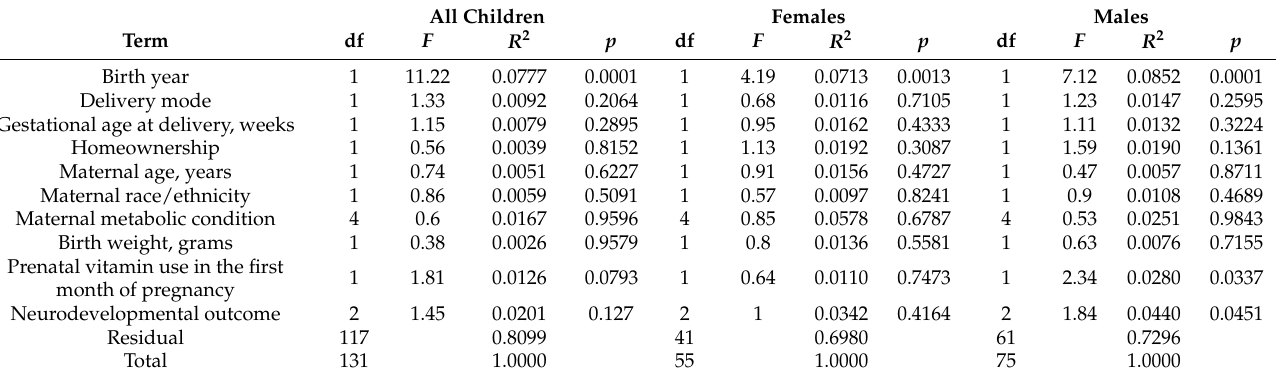
Table 4. The permutational multivariate analysis of variance (PERMANOVA) to assess the associ- ation between the placenta metabolome and neurodevelopmental outcome stratified by the child of interest’s sex. Placental metabolites were log 10 -transformed. The marginal effects of terms were tested under 9999